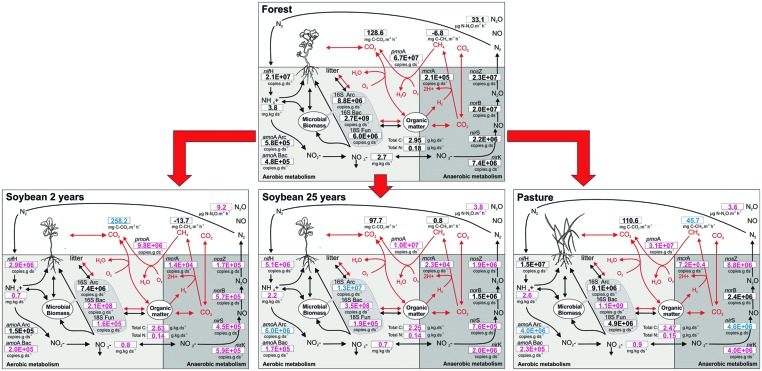
Integrated scheme for the carbon and nitrogen cycles in response to land use change in the soils of Southern Amazonia. The abundance of soil microbial genes involved in biogeochemical cycles of C and N are shown together with their respective end products. The forest was set as the reference value representing an unchanged control. Values that are modified with land use change from forest to soybean fields or pasture are indicated in color (increases in blue, and decreases in magenta; Tukey’s post hoc test, P < 0.05).